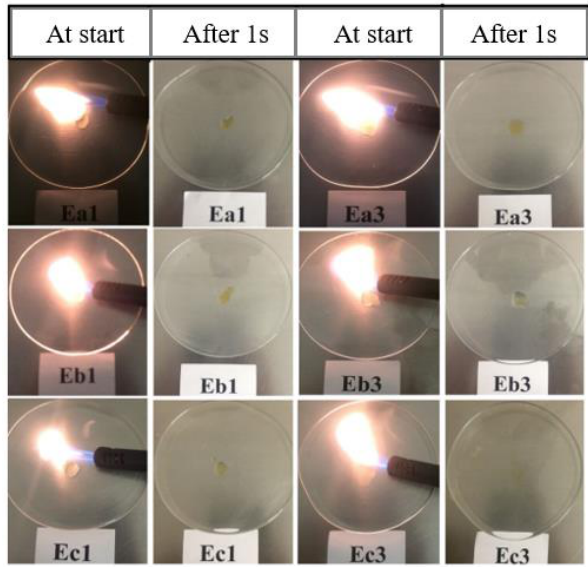
Figure 5. Development of the flames for different formulated electrolytes during the self-extinguishing time (SET) test directly at the burner was turned on (at the start) and was turned off (after 1 s), respectively (see Table 5 for the sample/formulation number) [33].